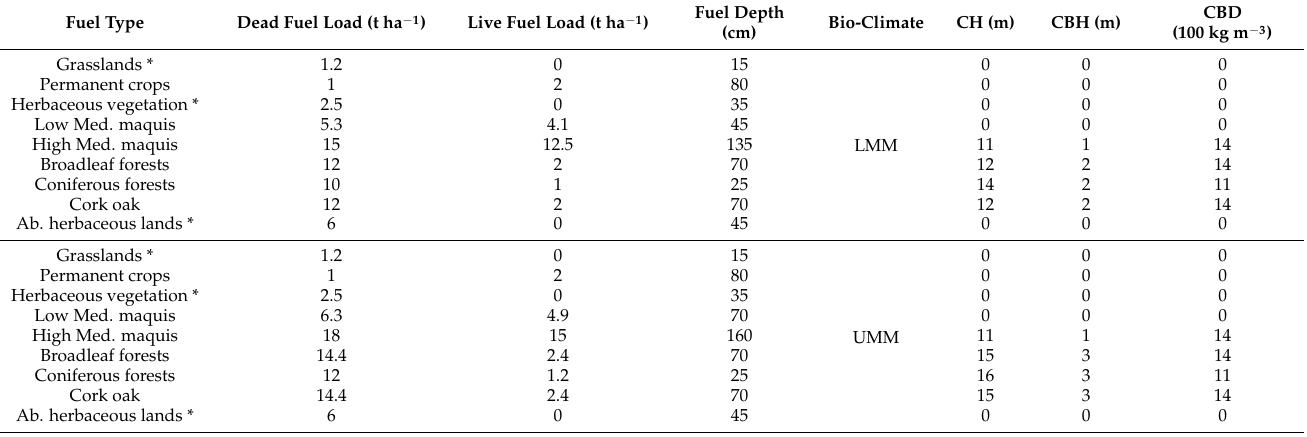
Table 1. Fuel model data was used for the wildfire simulations. A different combination of fuel models was used depending on the bio-climatic conditions of the study area, as described in the Methods. CH = canopy height; CBD = canopy bulk density; CBH = canopy base height. LMM = lower mesomediterranean; UMM = upper